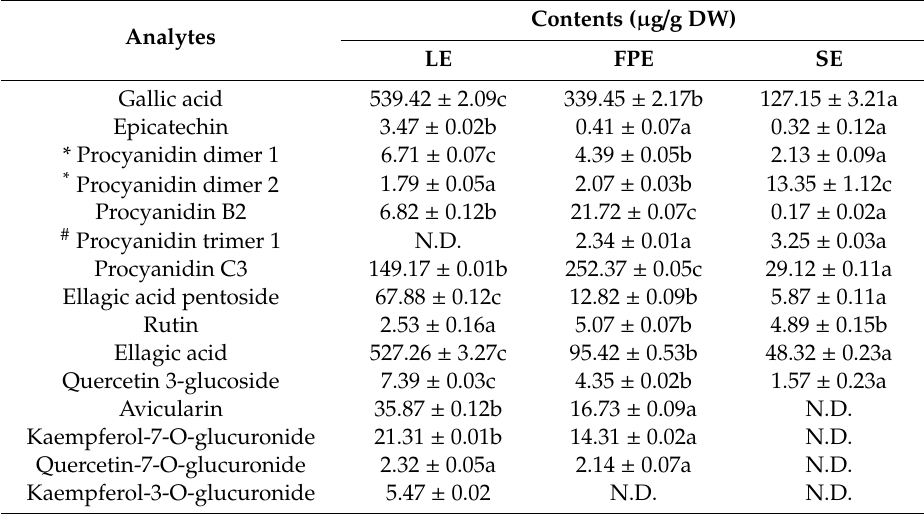
Table 2. Contents of the main individual phenolics of various parts in